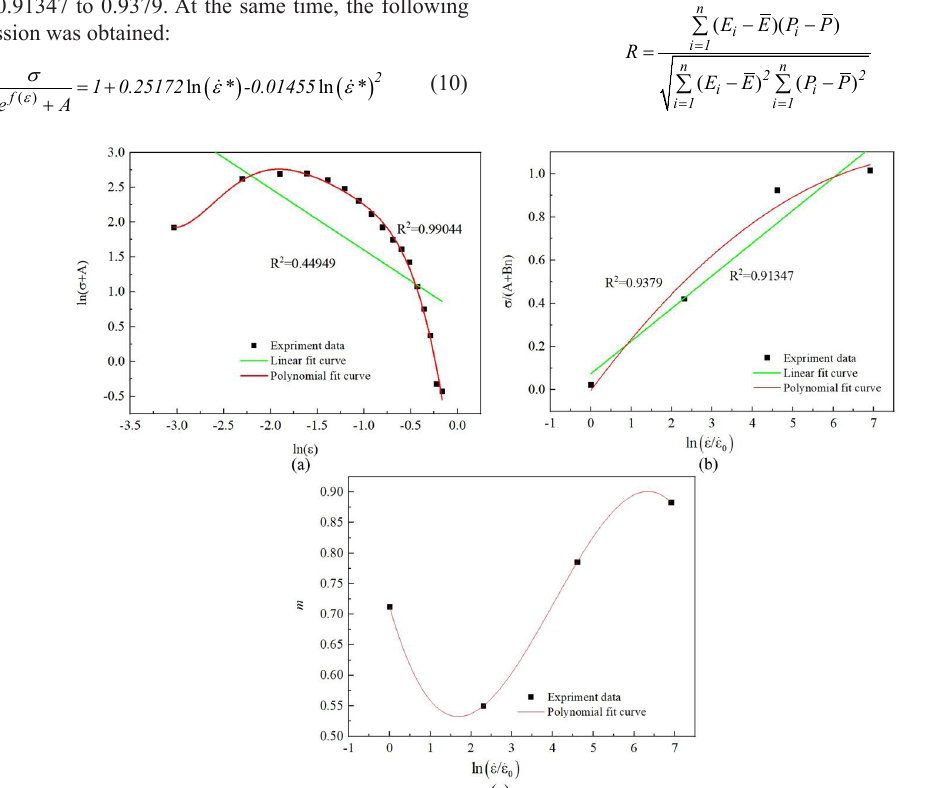
Figure 7. (a) Fitting error analysis of n and (b) C , (c) the fitting curve of